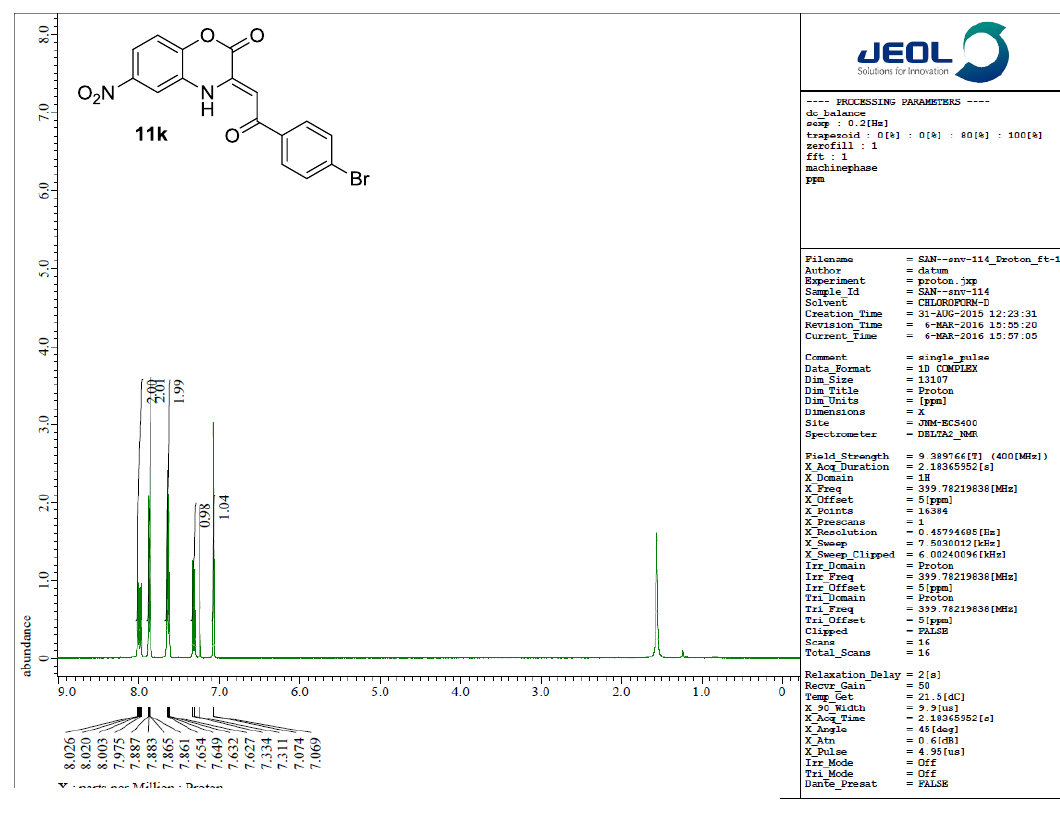
Figure 21. 1 H NMR Spectra of Compound 11k.